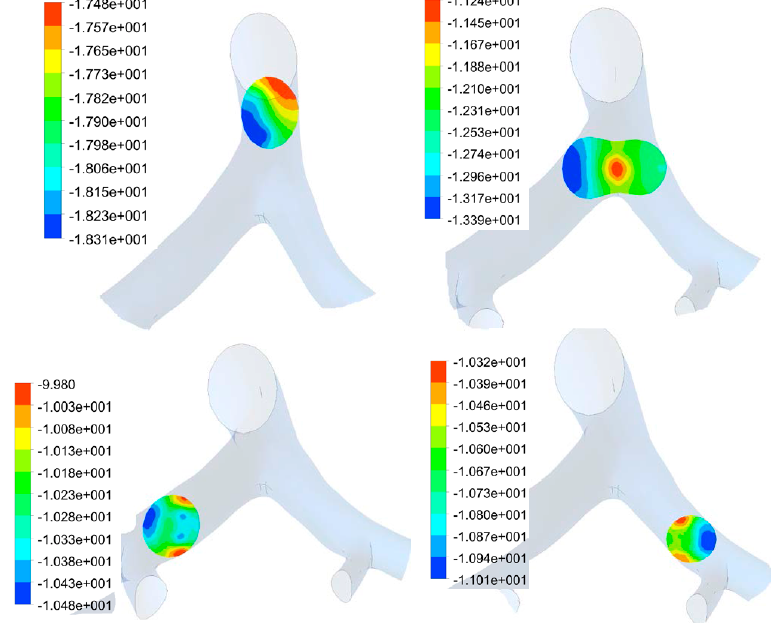
Figure 5. Pressure distribution in lung airway at several locations along airway at t = 0.5 s (peak expiration) on four section, including junction. Color legend shows pressure value range in Pascal.